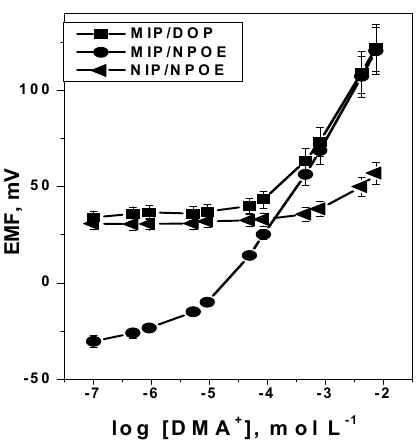
Figure 4. Response curves of: MIPs and NIP membrane based sensors in 5.0 × 10 − 3 mol·L − 1 Trizma buffer of pH 7.1 .